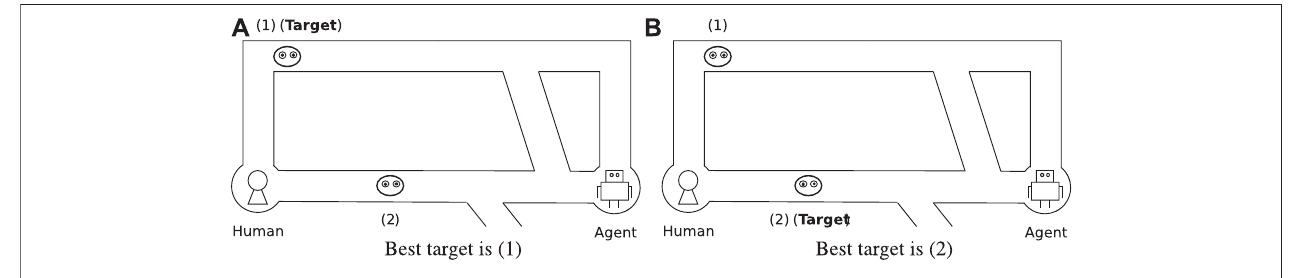
FIGURE 1 | Example of complex human-agent team task.